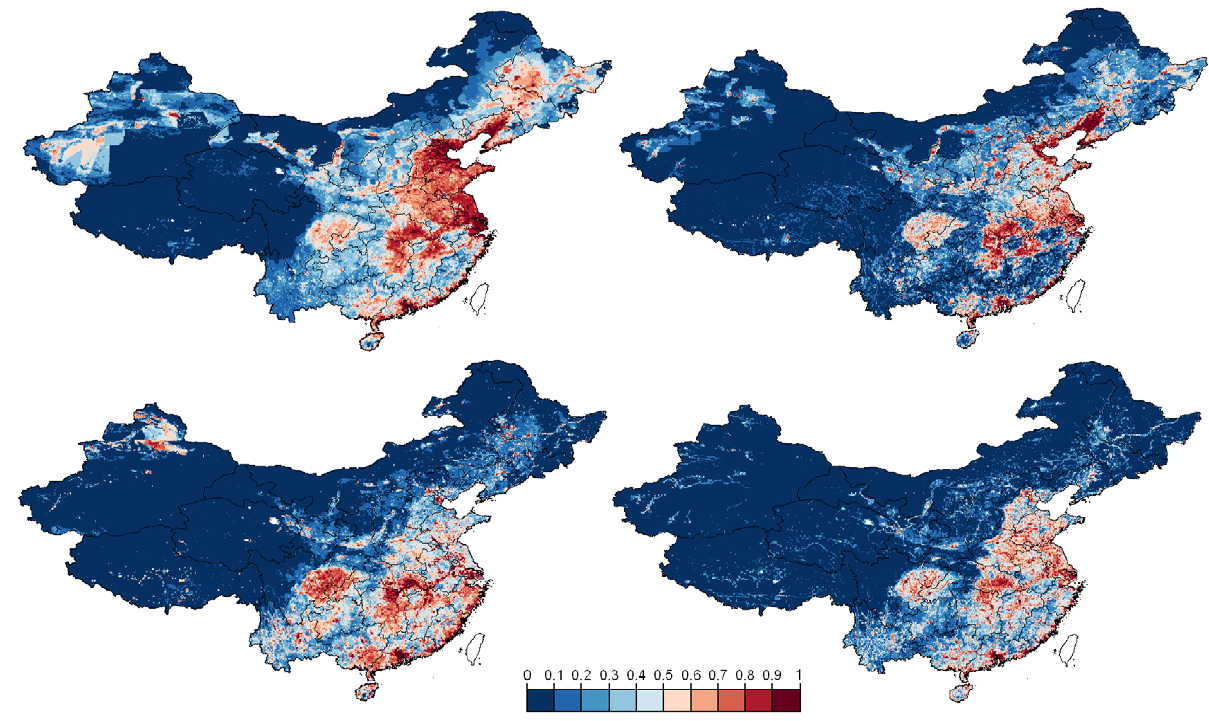
Figure 4. Predicted distribution of HPAI H5N1 risk. Predictions are displayed according to the bootstrapped logistic regression model (left) and boosted regression trees (right), based on reported HPAI H5N1 clinical disease outbreak data (top), or HPAIV H5N1 risk-based surveillance data (bottom).